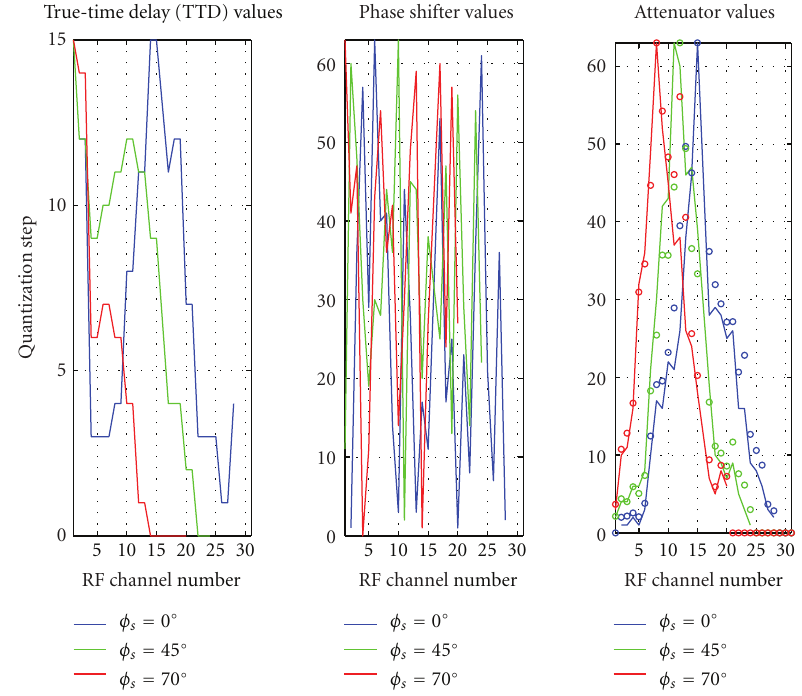
Figure 7: Experimentally optimised settings for the true-time delay (TTD), phase shifter, and attenuator settings in RX-operation for three di ff erent electronic scan angles. Ideal attenuator values are denoted by